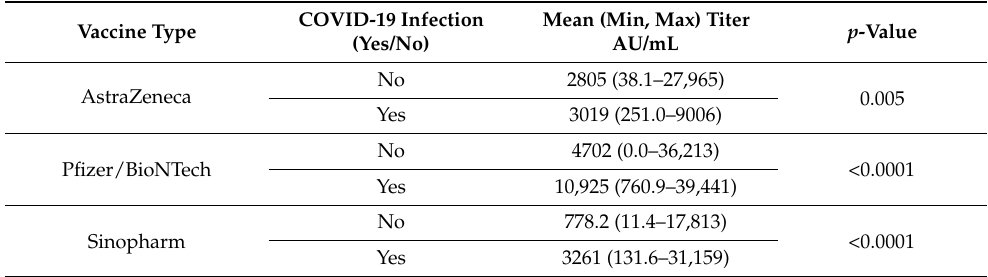
Table 5. The effect of COVID-19 infection on the mean titer of neutralizing IgG antibodies in HCWs vaccinated with three main types of